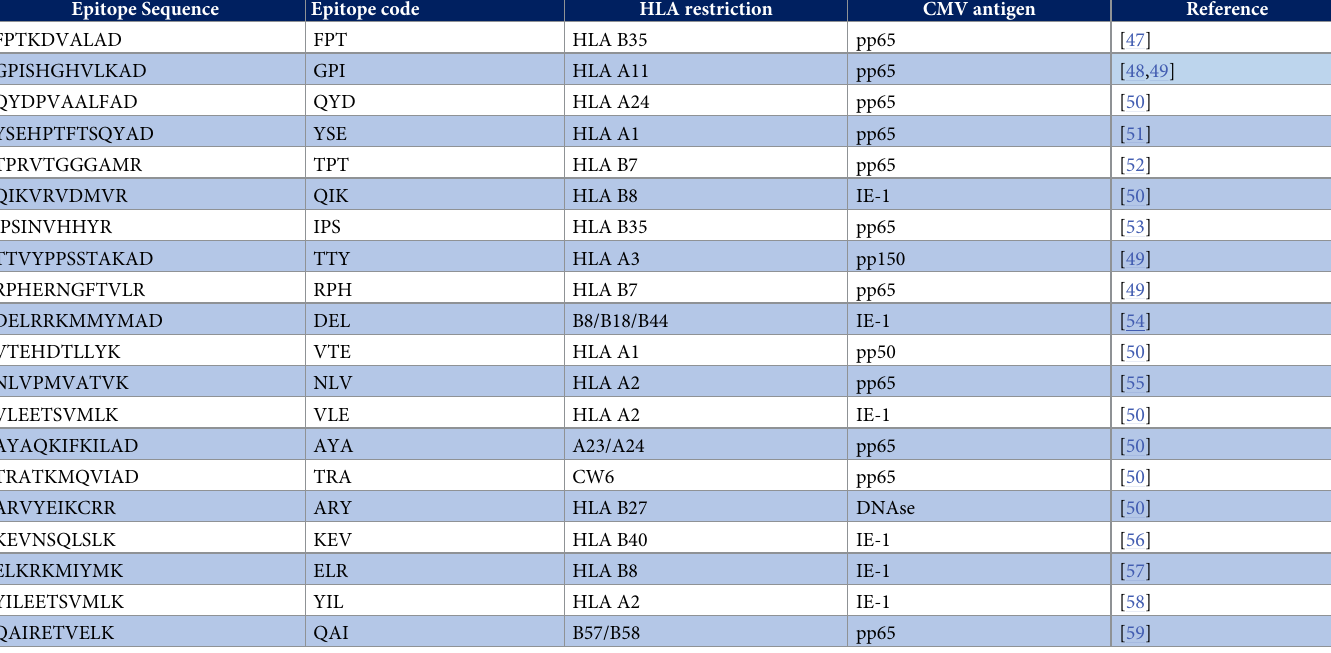
Table 1. List of HLA class I-restricted CD8 + T cell epitopes included in the CMVpoly protein. Epitope Sequence Epitope code HLA